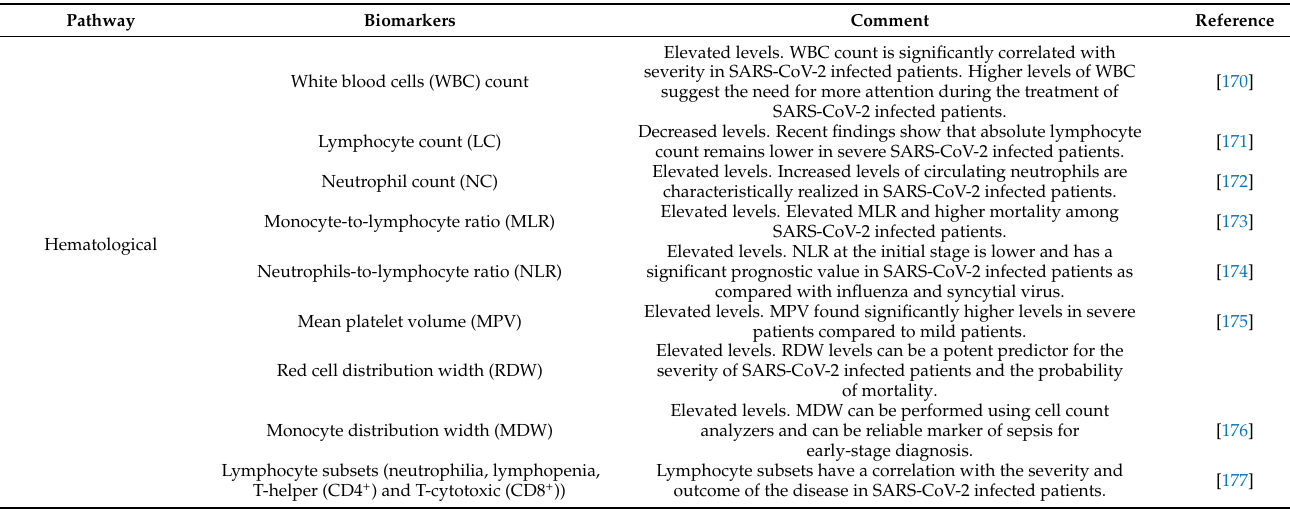
Table 2. List of potential biomarkers of SARS-CoV-2 infection. Pathway